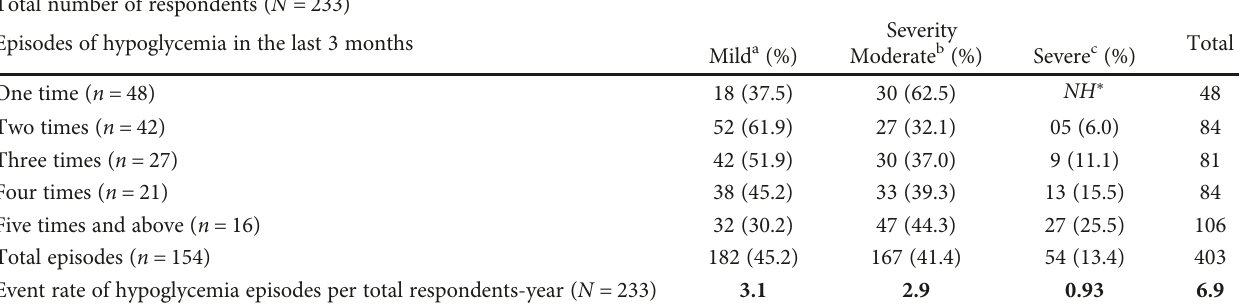
Table 3: Frequency of hypoglycemia events and their severity distribution in the last three months among ambulatory T1DM patients attending the diabetes clinics of SPHMMC from June 01 to August 01,